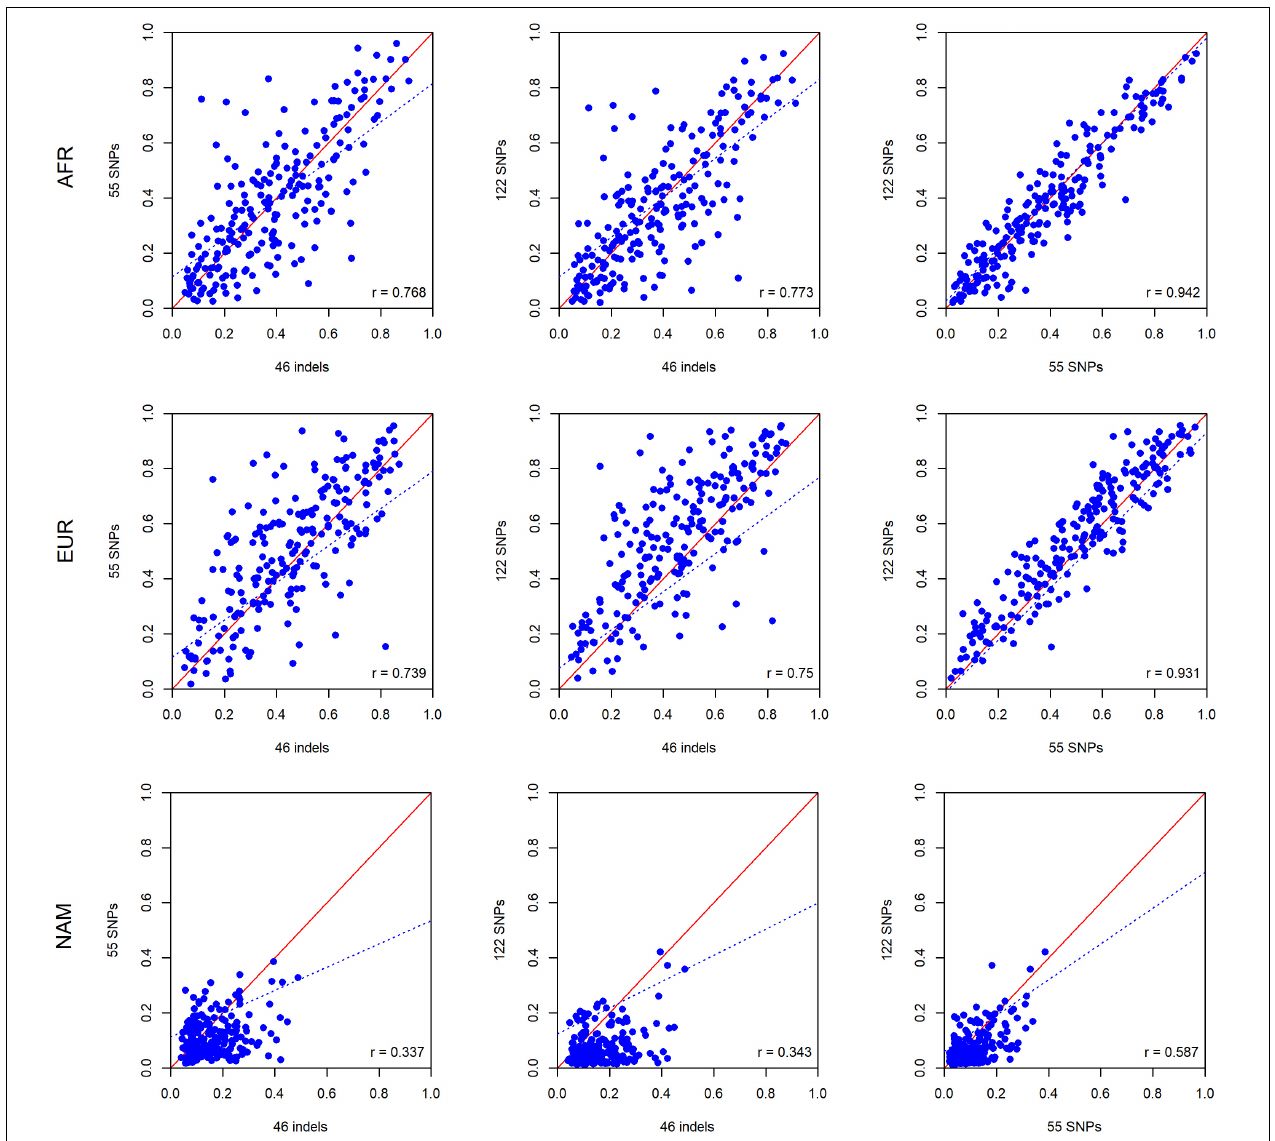
FIGURE 8 | Pairwise comparisons between ancestry estimates provided by the panels with 46 indels, 55 SNPs, and 122 SNPs among the unrelated individuals from the Rio de Janeiro population. The respective r -values are indicated in the figures, and the tendency line is represented as a blue dashed line. The red solid line indicates the perfect agreement between two AIM